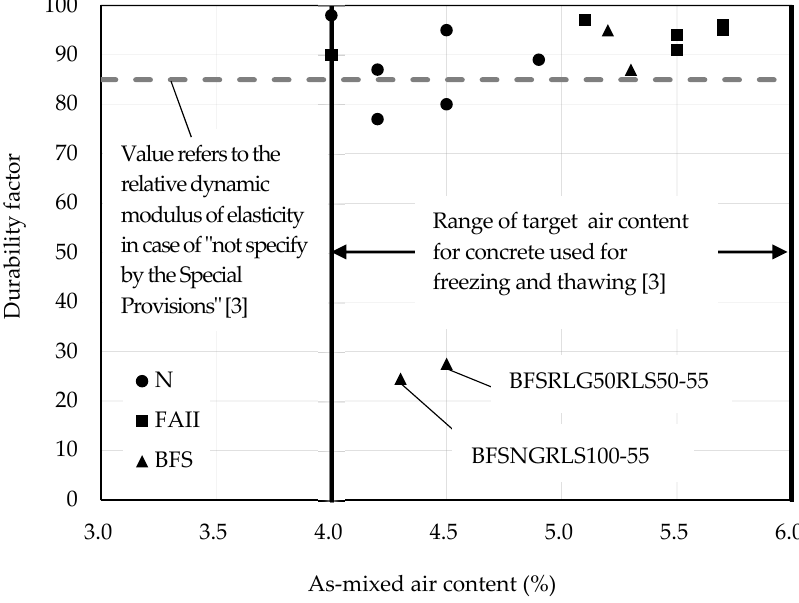
Figure 8. Relationship between as-mixed air content and durability factor.